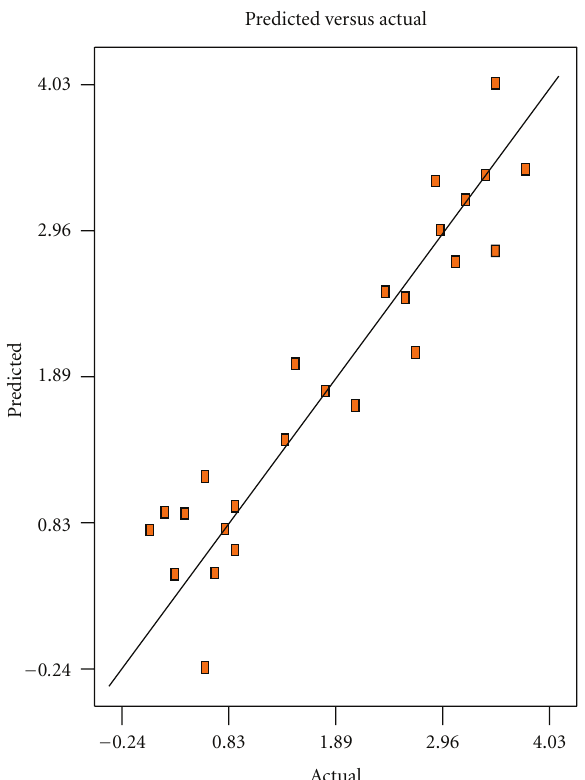
Figure 3: Predicated versus actual plot of Y (HYOOA).